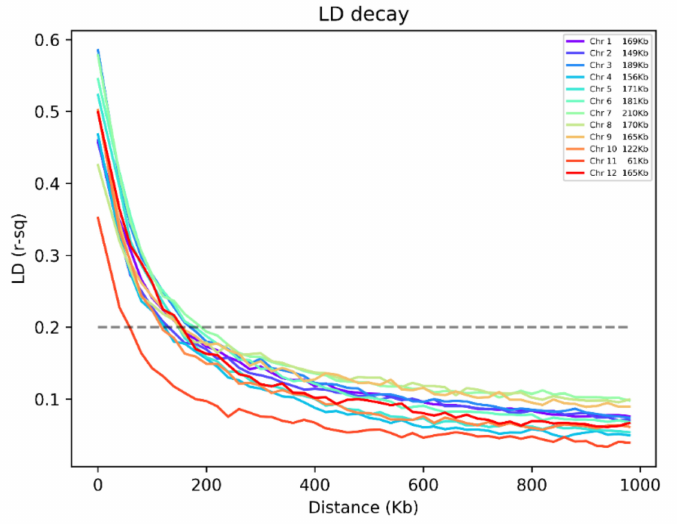
Figure 4. Linkage disequilibrium decay across 12 chromosomes in 222 O. sativa accessions. Mean LD decay ranges between 61–210